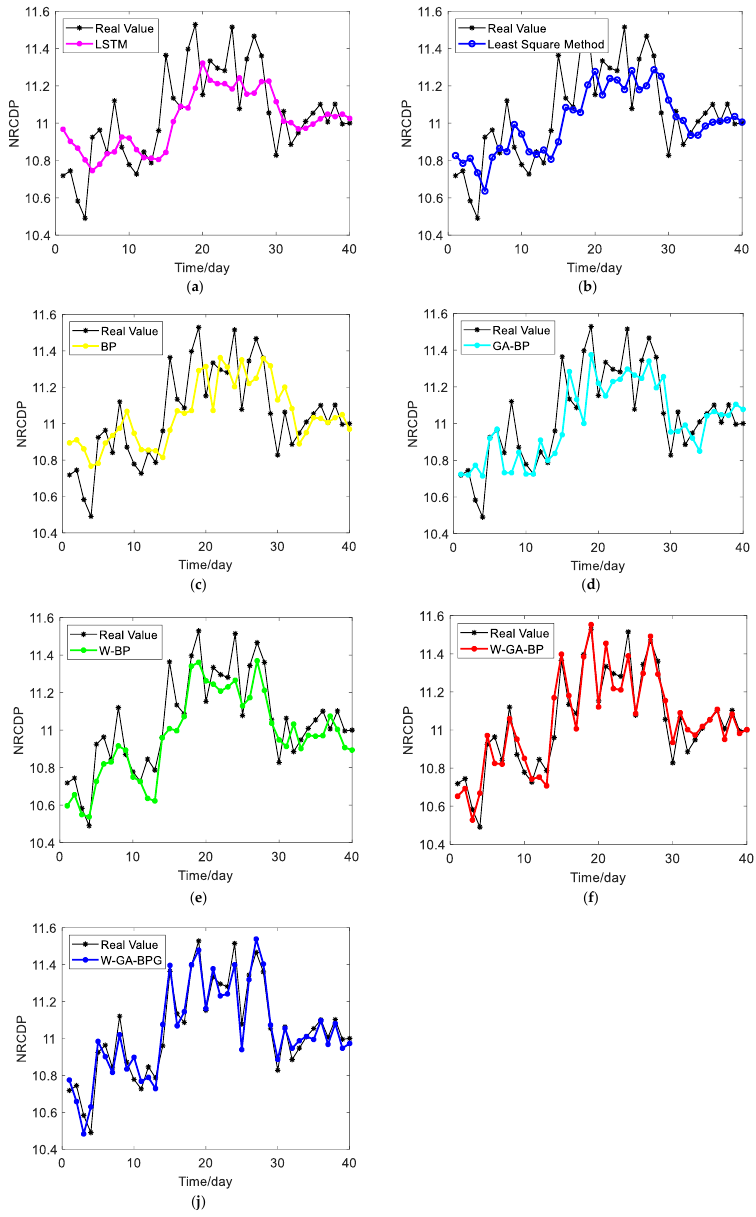
Figure 7. Prediction results for ( a ) LSTM, ( b ) Least Square, ( c ) BP, ( d ) GA-BP, ( e ) W-BP, ( f ) W-GA- BP and ( j ) W-GA-BPG.